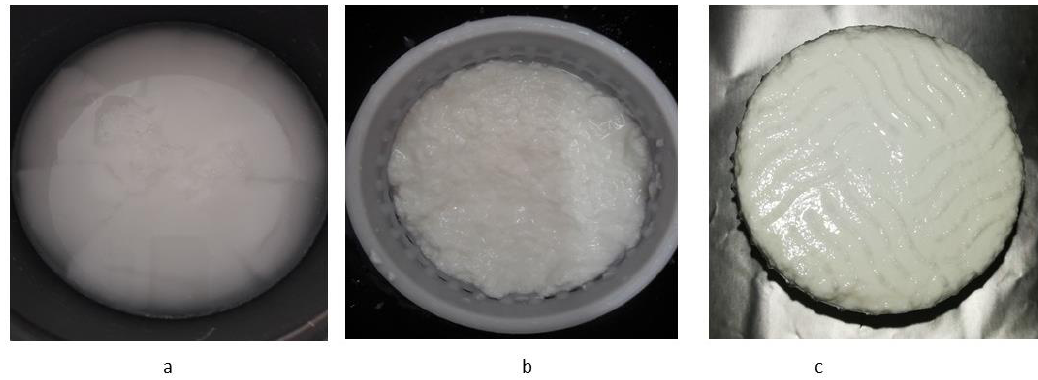
Figure 2. Donkey cheese manufacturing: curd at the cutting time ( a ); moulded curd ( b ); cheese after 24 h ( c ).